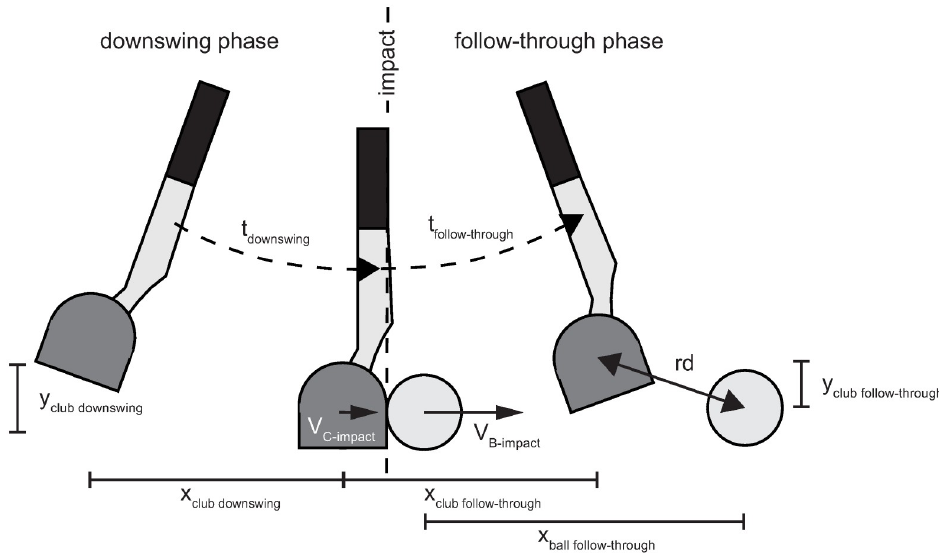
Fig 6. Stimuli description. Schematic representation of t downswing = duration of the downswing phase; v C-impact = resulting velocity of the club head before the impact; x club downswing = distance covered by the club head in x-direction in the downswing phase; y club downswing = distance covered by the club head in y-direction in the downswing phase; v B-Impact = resulting velocity of the ball after the impact; t follow-through = duration of follow-through phase; x club follow- through = distance covered by the club head in x-direction in the follow-through phase; y club follow-through = distance covered by the club head in y-direction in the follow-through phase; x ball follow-through = distance covered by the ball in x-direction in the follow-through phase; rd = radial distance between club head and ball.